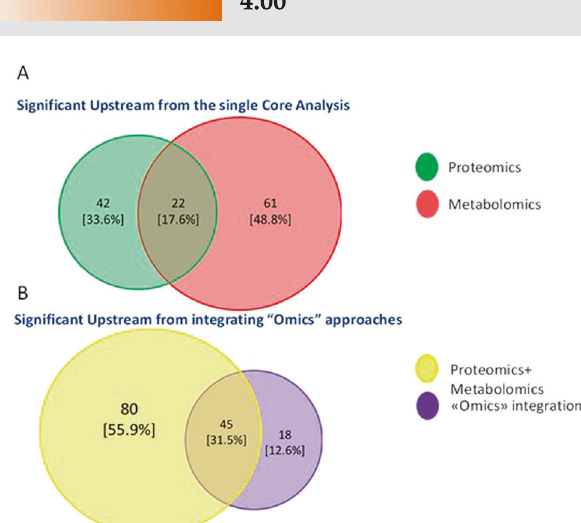
Fig. 1 Upstream Regulator Analysis Results. A Venn diagram for signi fi cant upstream (both activated and inhibited) from the single “ Core Analysis ” using IPA tool based on Proteomics (in green), or Metabolomics (in light red). B Venn Diagram for signi fi cant upstream (both activated and inhibited) from integrating “ Omics ” approaches (in violet) vs the sum of the signi fi cant upstream obtained by each single approach (Proteomics + Metabolomics, in